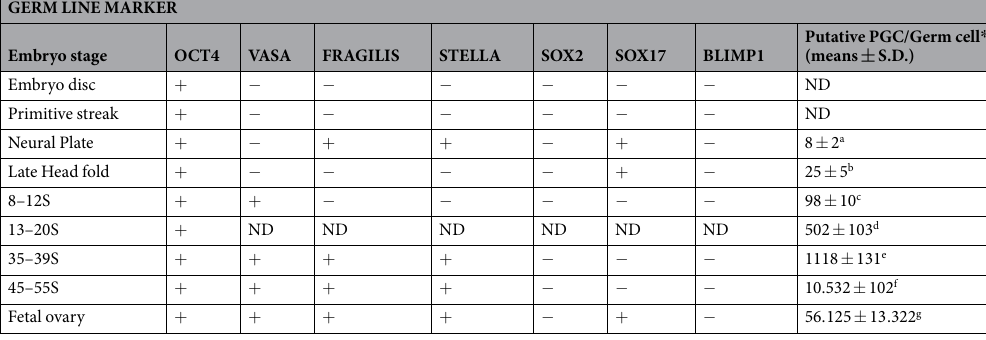
Table 1. Germ line marker detection and quantification of OCT4-positive cells throughout embryonic development in L. maximus . * The number of putative PGCs/germ cells was estimated on the basis of OCT4- positive cells. Different letters in the. last column indicate significant differences ( p < 0.05). S: somites. + : positive cells. − : Not detected. ND: not